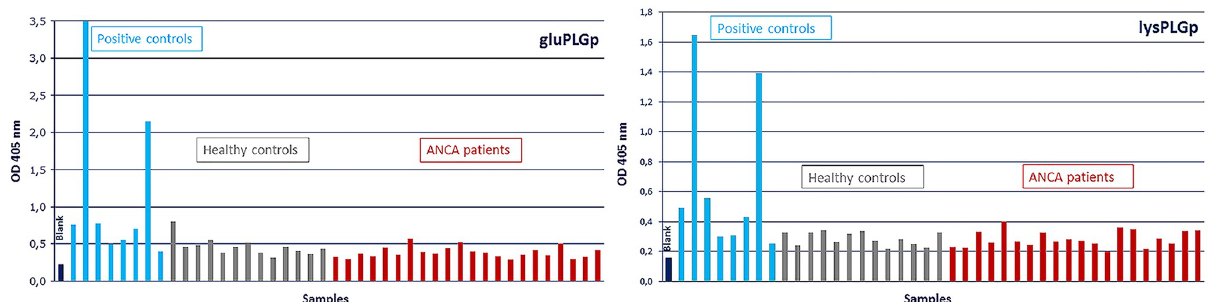
Fig 2. Spectrophotometrical results. (A) Spectrophotometrical results using purified glutamic acid plasminogen as an antigen in the assay. Optical density was measured with spectrometry using light of 405 nanometer for the detection of anti-plasminogen antibodies in the serum samples. (B) Spectrophotometrical results using purified lysine-plasminogen as an antigen in the assay. Optical density was measured with spectrometry using light of 405 nanometer for the detection of anti-plasminogen antibodies in the serum samples. Purified lysine-plasminogen showed more spectrophotometrical differentiation between positive samples and negative samples compared to purified glutamic acid plasminogen (Fig 2A). Abbreviations: gluPLGp, purified glutamic acid plasminogen; OD, optical density; nm, nanometer; lysPLGp, purified lysine-plasminogen.